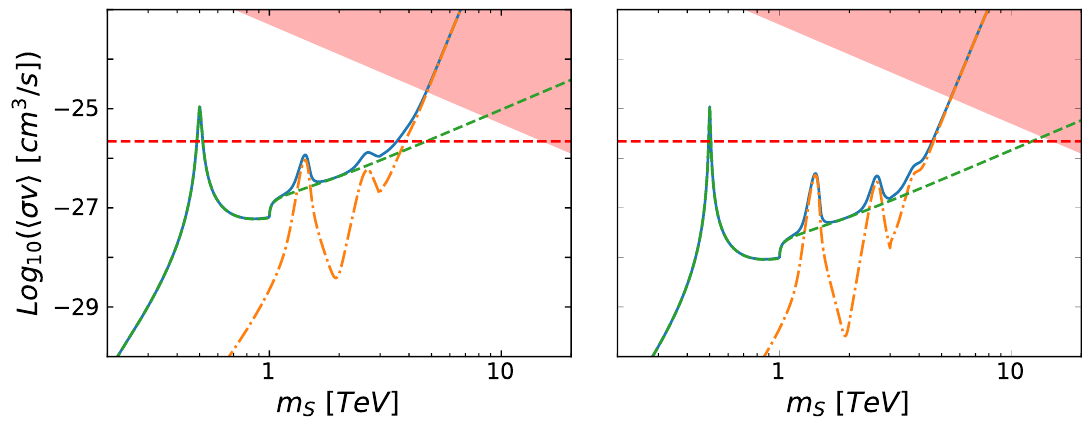
Figure 4 . The thermally-averaged scalar DM annihilation cross-section through virtual radion exchange and direct production of two radions, (cid:27) r = (cid:27) ve ;r + (cid:27) rr (green, dashed line), as a function of the DM mass m S , compared with the corresponding cross-section through KK-graviton exchange and production, (cid:27) G (orange, dot-dashed line). The sum of the two cross-sections, (cid:27) r + (cid:27) G , is represented by the (blue) solid line. Left panel: (cid:3) = 5 TeV, m G = 3 TeV and m r = 1 TeV; Right 1 panel: (cid:3) = 8 TeV, m G = 3 TeV and m r = 1 1